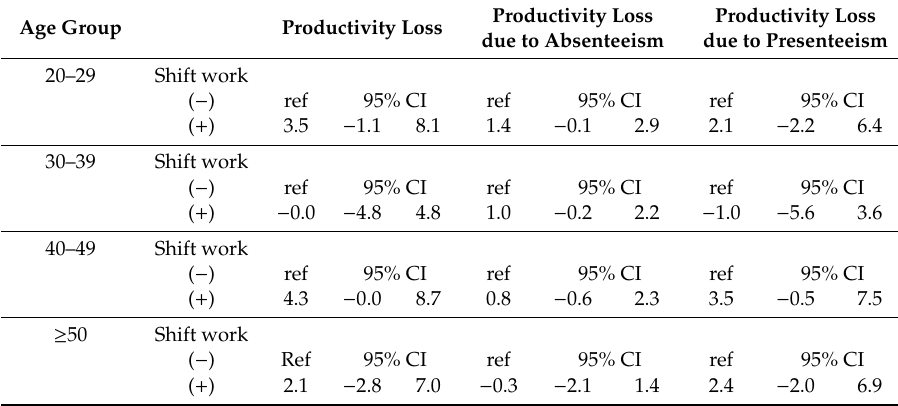
Table A1. Age-group-stratified productivity loss due to shift work (Unit: percent